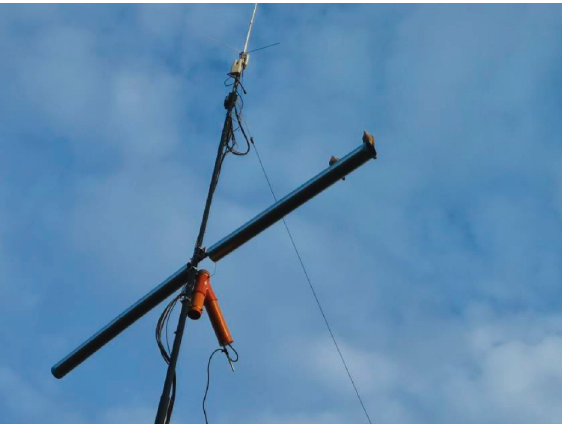
Figure 4: The adapted shorted dipole and the ITA LWA II 20-meter-long wire antenna (from top to lower